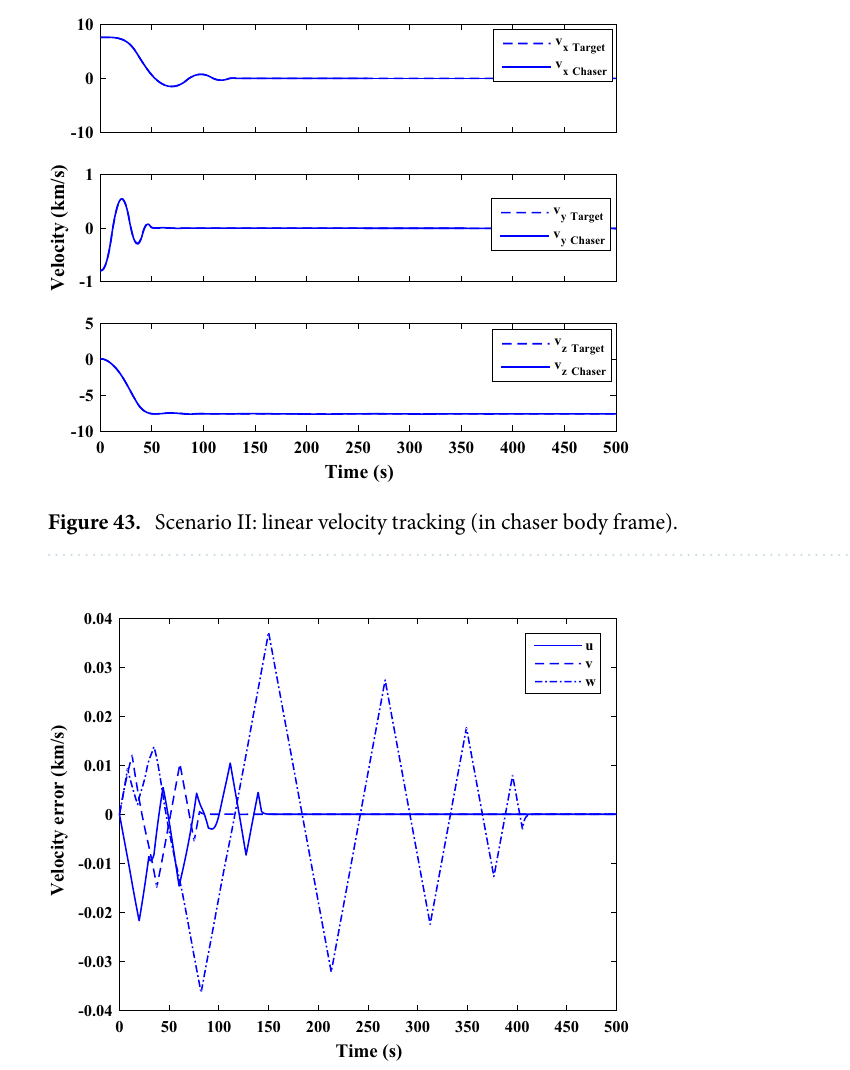
Figure 44. Scenario II: relative linear velocity error (in chaser body frame).